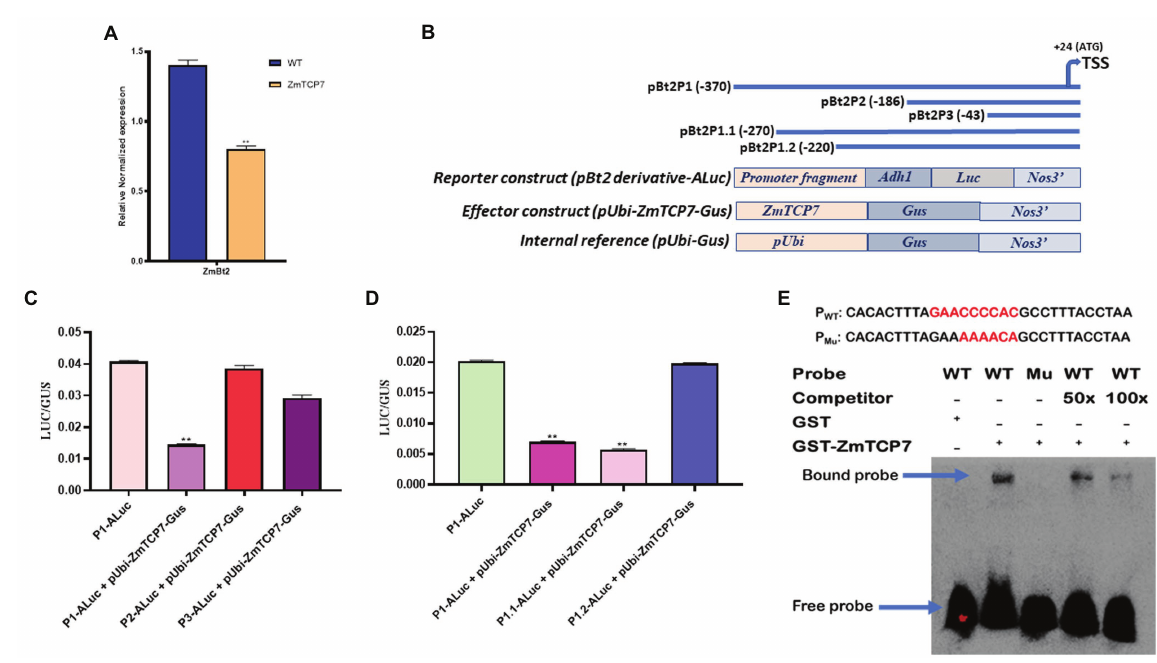
(Figure 4A). Interestingly, the repressive influence of ZmTCP7 was completely eliminated in the cells transfected with p Bt2 P2- ALuc + pUbi-ZmTCP7-Gus (Figure 4C), indicating that the promoter region between p Bt2 P1 ( − 370) and p Bt2 P2 ( − 186),